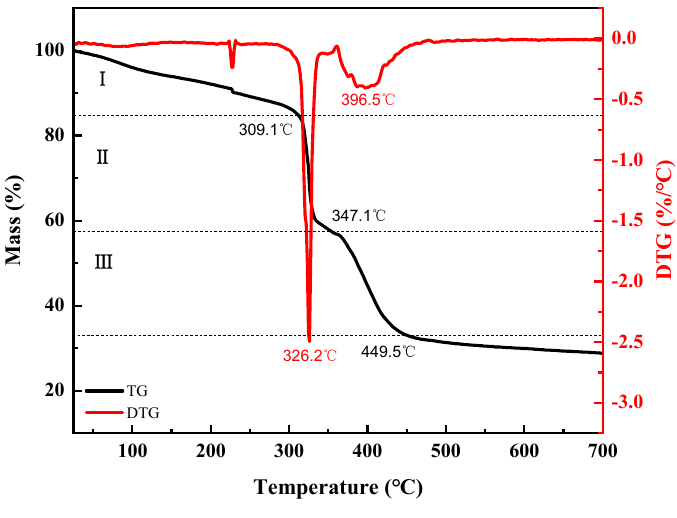
Figure 3. TGA curve of AADN.